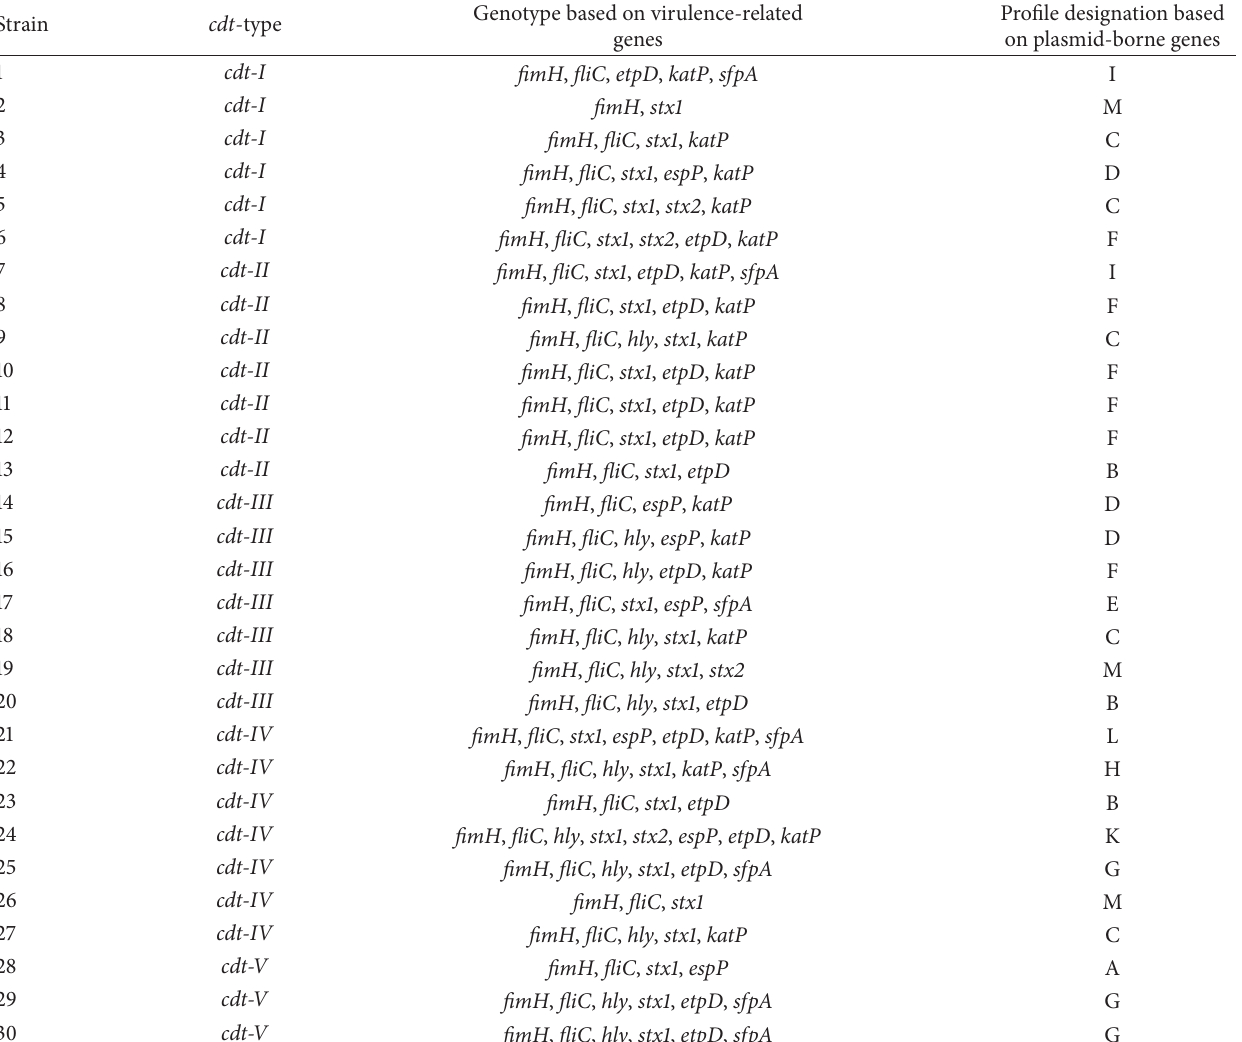
Table 4: Different cdt -type strains and related genotype based on other virulent genes and profile designation based on cooccurrence of plasmid-borne genes. espP : profile A, etpD : profile B, katP : profile C, espP/katP : profileD, espP/sfpA : profile E, etpD/katP : profile F, etpD/sfpA : profile G, katP/sfpA : profile H, etpD/katP/sfpA : profile I, espP/etpD/katP : profile K, espP/etpD/katP/sfpA : profile L, and profile M: Indicates the absence of plasmid genes and presence of chromosomal genes ( fimH , fliC , hly , stx1, or stx2